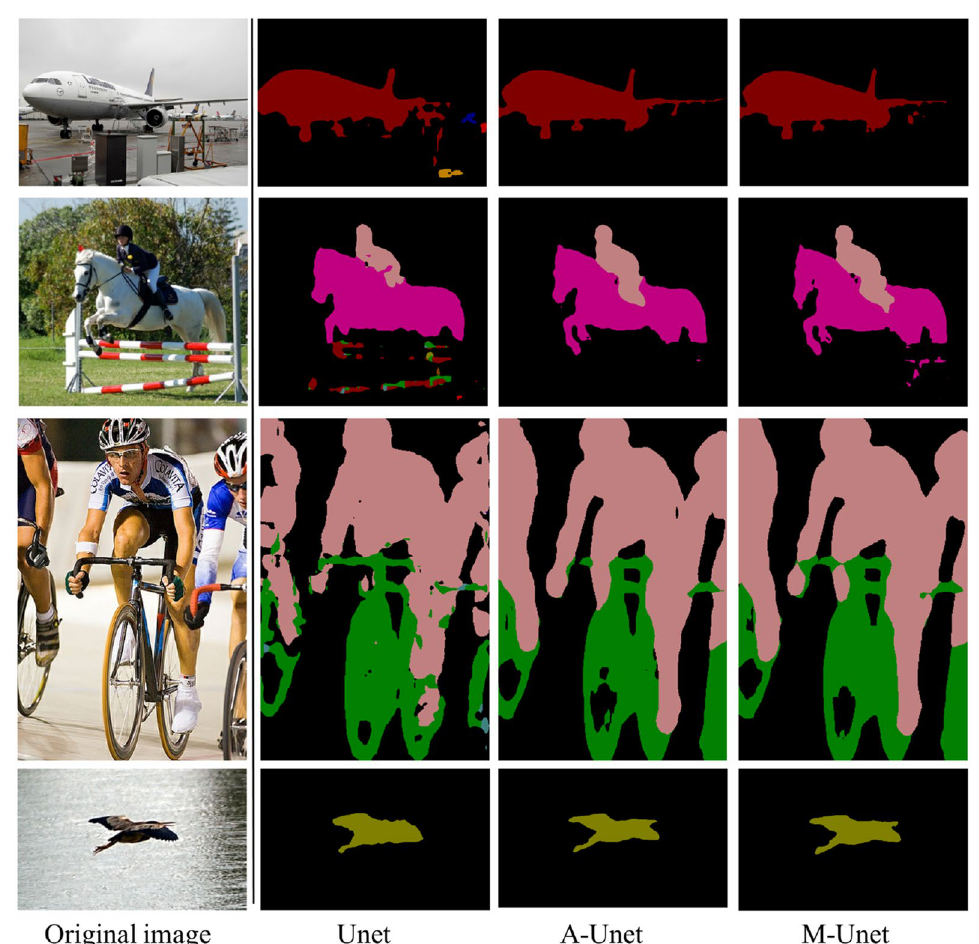
Figure 15 Several examples of segmentation results obtained by different neural networks